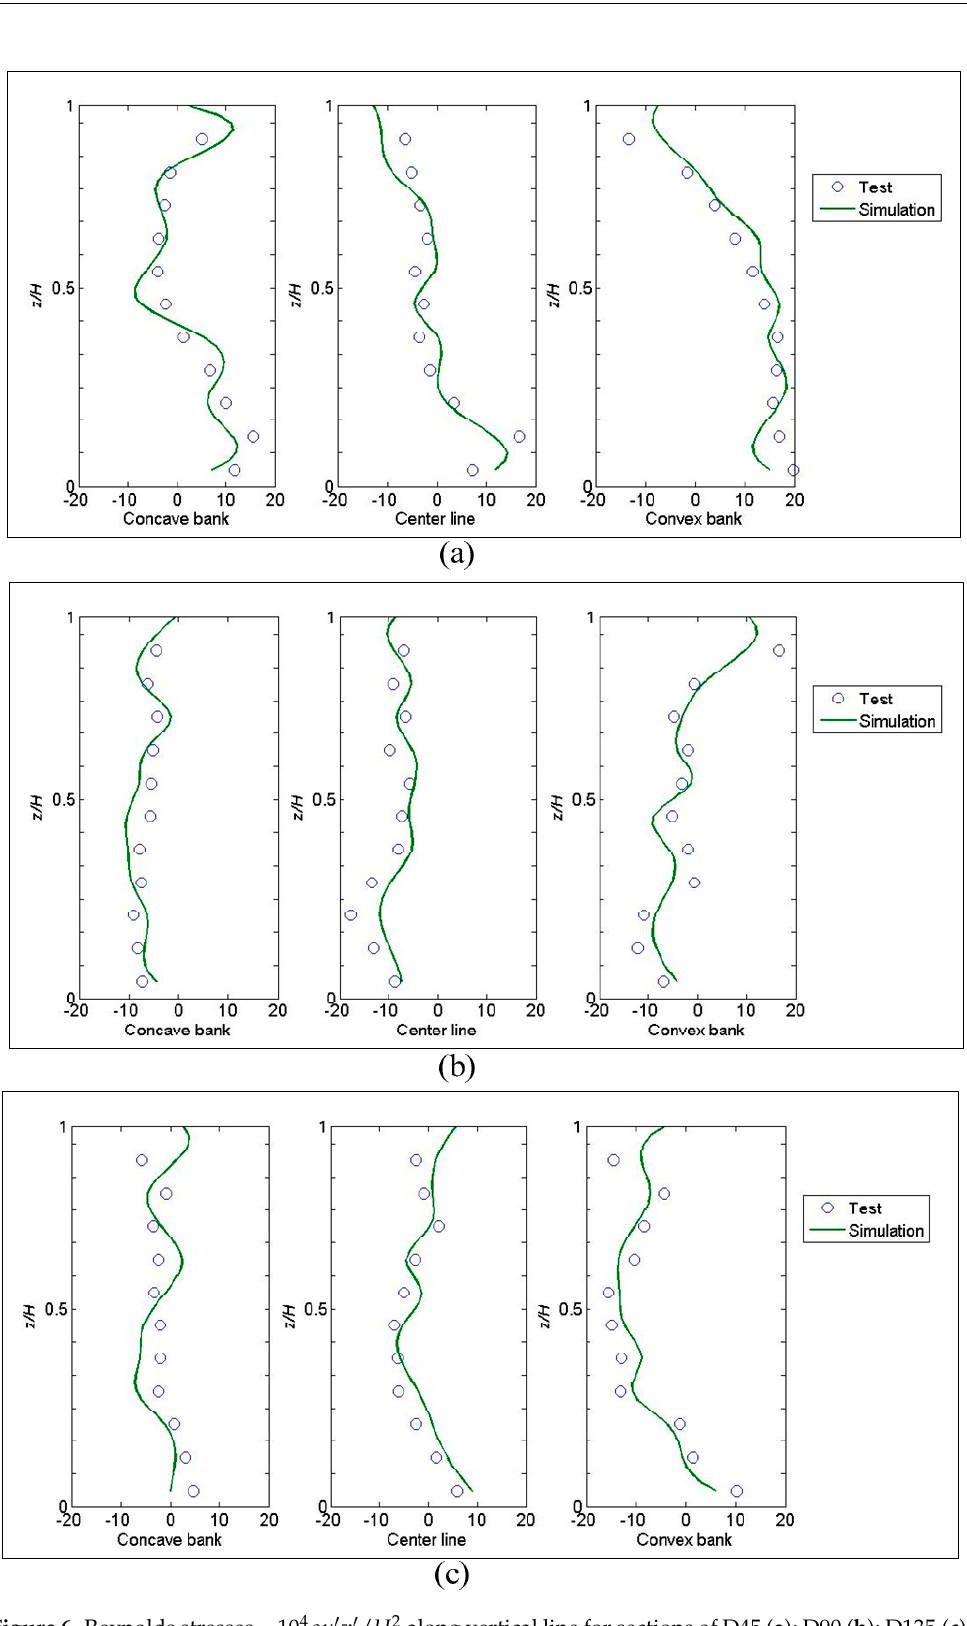
Figure 6. Reynolds stresses − 10 4 ρ u (cid:48) v (cid:48) / U 2 along vertical line for sections of D45 ( a ); D90 ( b ); D135 ( c ).